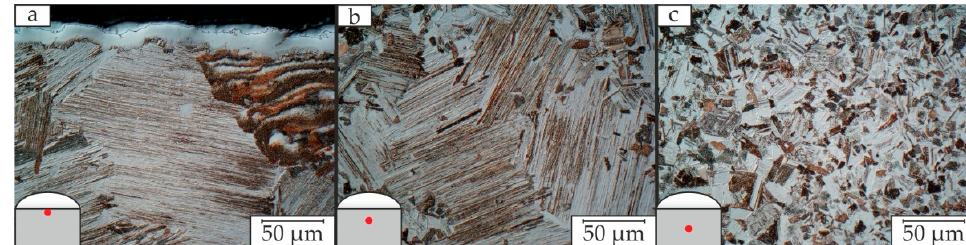
Figure A3. Microstructure in defined positions a, b and c according to Figure 1 (right) of a GE48 sample sintered at 1300 °C, with 2 min dwell time and 30 MPa pressure.